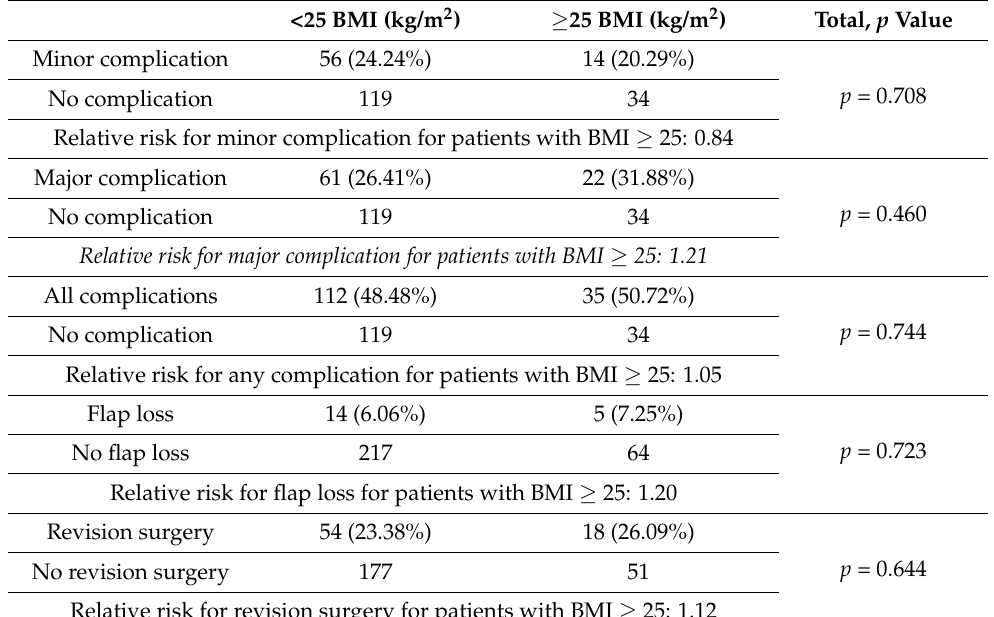
Table 5. Comparison of patients with higher BMI and over 50 years to younger patients with lower BMI. ≥ 25 BMI (kg/m 2 ) and Total, <25 BMI (kg/m 2 ) and ≥ 50 Years p Value < 50 Years Minor complication 34 (26.77%) 7 (24.14%) p = 0.931No complication 66 13 Relative risk for minor complication for patients with BMI ≥ 25 and over 50: 0.90 Major complication 29 (22.83%) 9 (31.03%) p = 0.349No complication 66 13 Relative risk for major complication for patients with BMI ≥ 25 and over 50: 1.36 All complications 61 (48.03%) 16 (55.17%) p = 0.488No complication 66 13 Relative risk for any complication for patients with BMI ≥ 25 and over 50: 1.15 Flap loss 8 (6.30%) 2 (6.90%) p = 0.906No flap loss 119 27 Relative risk for flap loss for patients with BMI ≥ 25 and over 50: 1.10 Revision surgery 25 (19.69%) 7 (24.14%) p = 0.592No revision surgery 102 22 Relative risk for revision surgery for patients with BMI ≥ 25 and over 50: